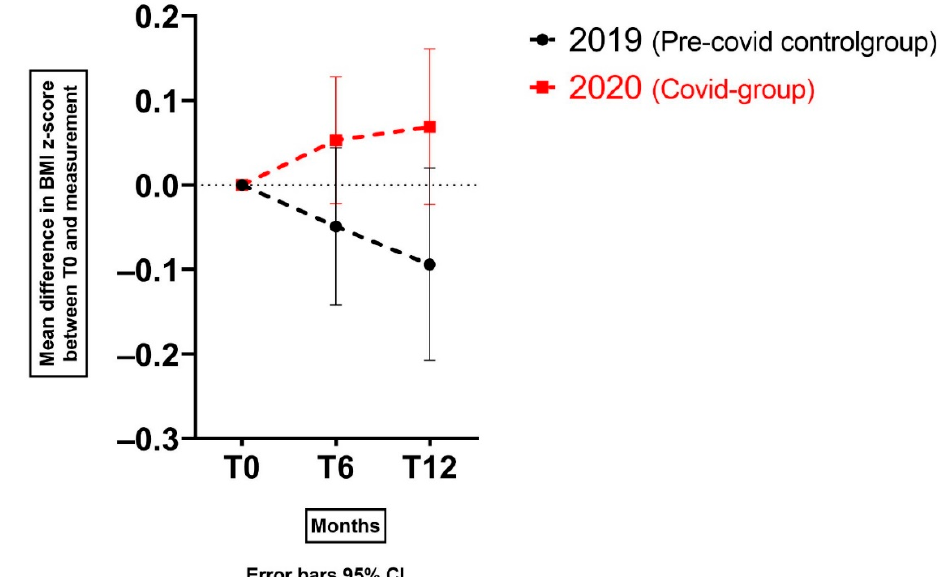
Figure 2. Change in BMI z-score for children with overweight and (severe) obesity at T6 and T12 in